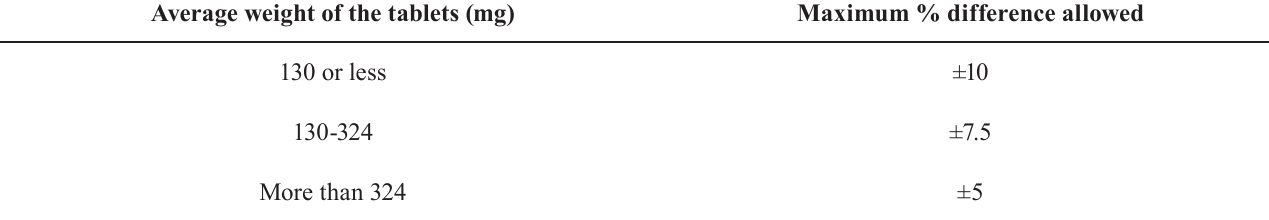
Average weight of the tablets